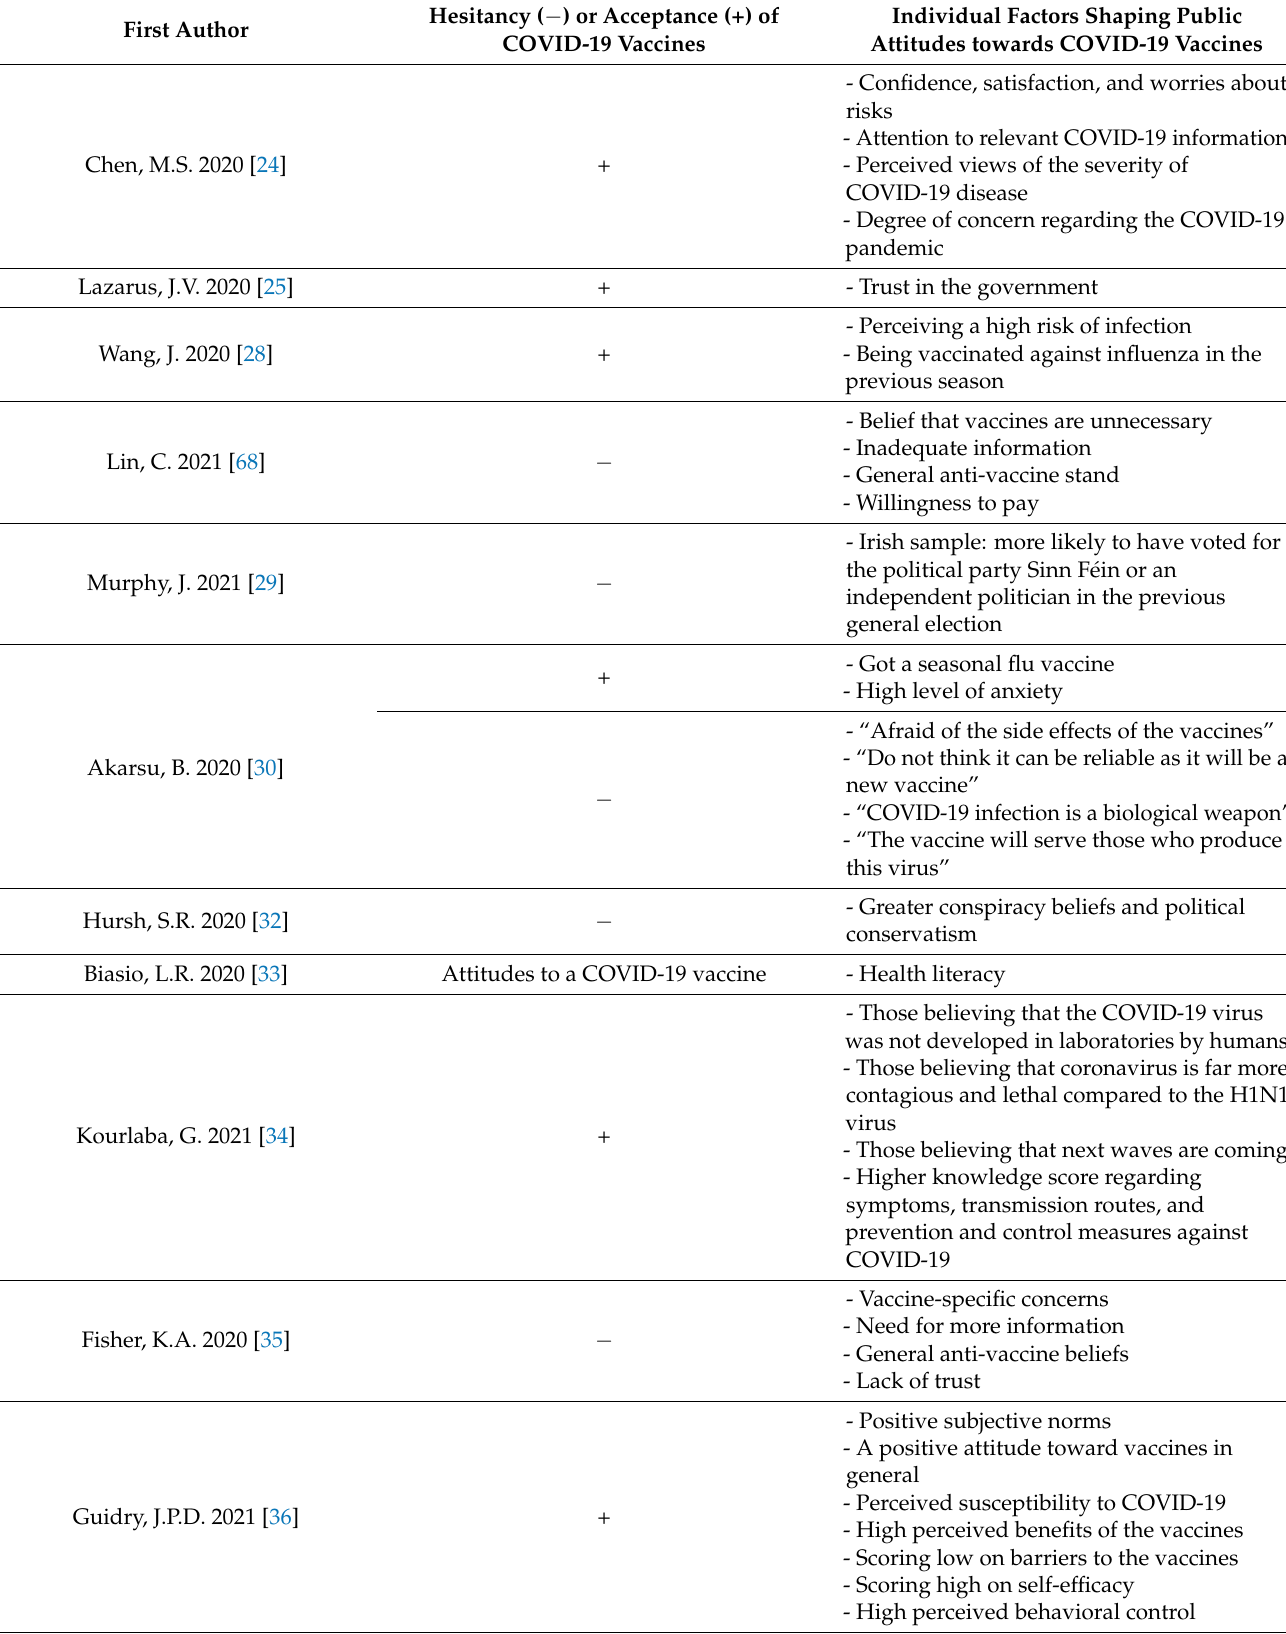
Table 4. Individual factors associated with hesitancy or acceptance of COVID-19